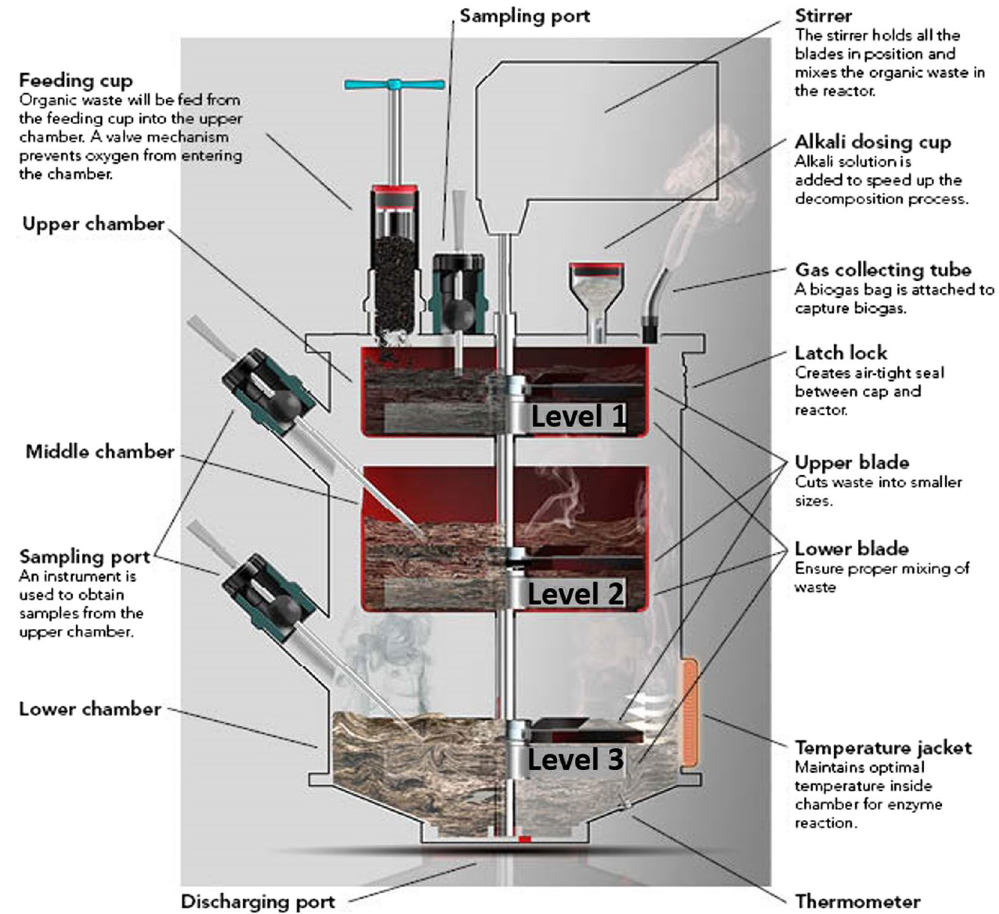
Figure 1. Schematic diagram of three-stage anaerobic digester